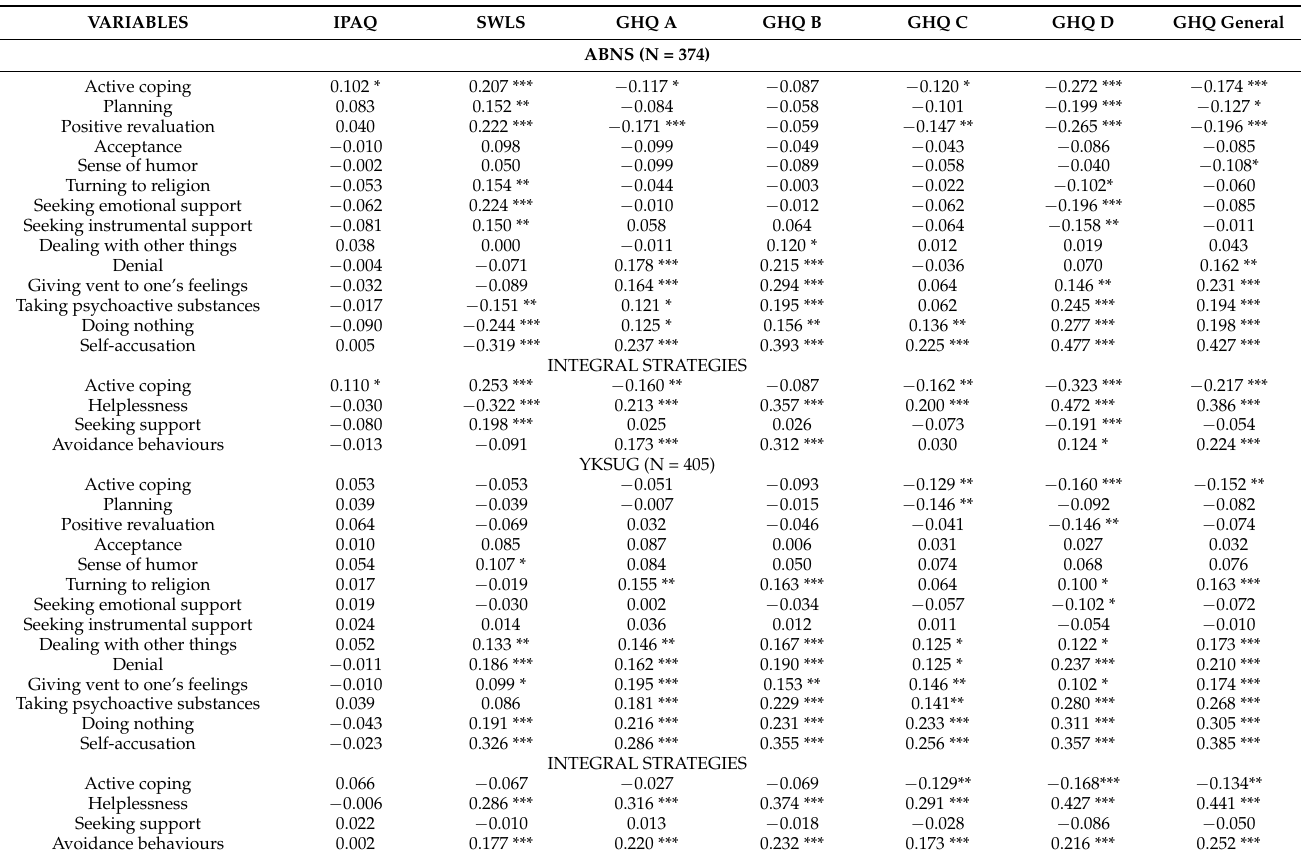
Table 8 shows correlations between coping with stress and physical activity, mental health and life satisfaction during the pandemic. In the case of strategies of coping with stress, the table includes both general factors that were highlighted by the tool developers as well as detailed strategies of coping with stress. Table 8. Correlations between coping with stress and physical activity, mental health and life satisfaction during COVID-19 pandemic (Spearman’s